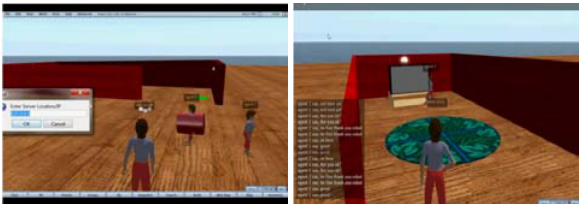
Figure 2. Snapshots from AF-agents controlling OpenSim